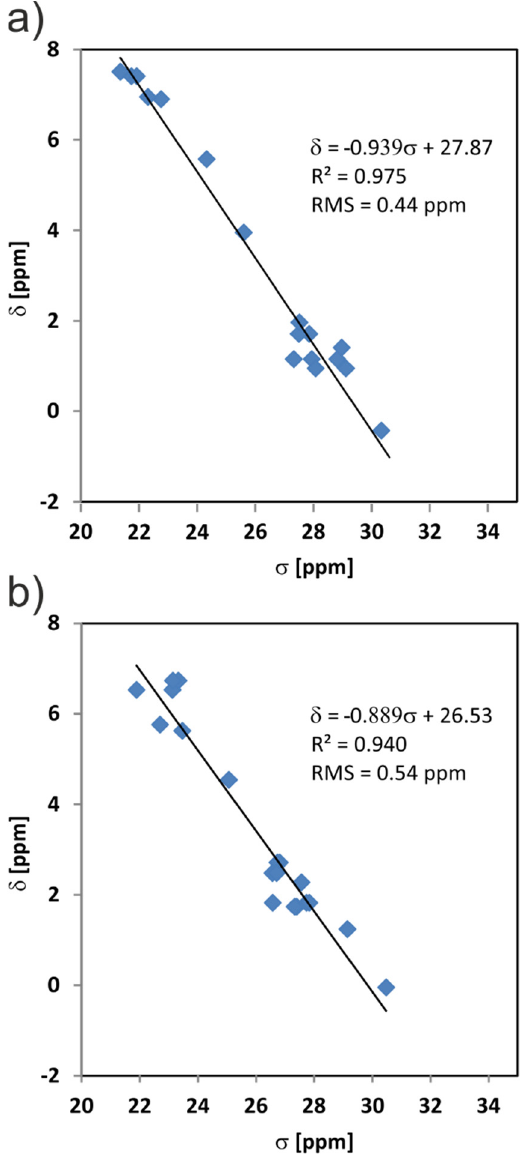
Figure 12. The correlation of experimental 1 H chemical shift values ( δ ) and calculated nuclear shielding ( σ ) values of the MBS ( a ) and MBS HCl ( b ).